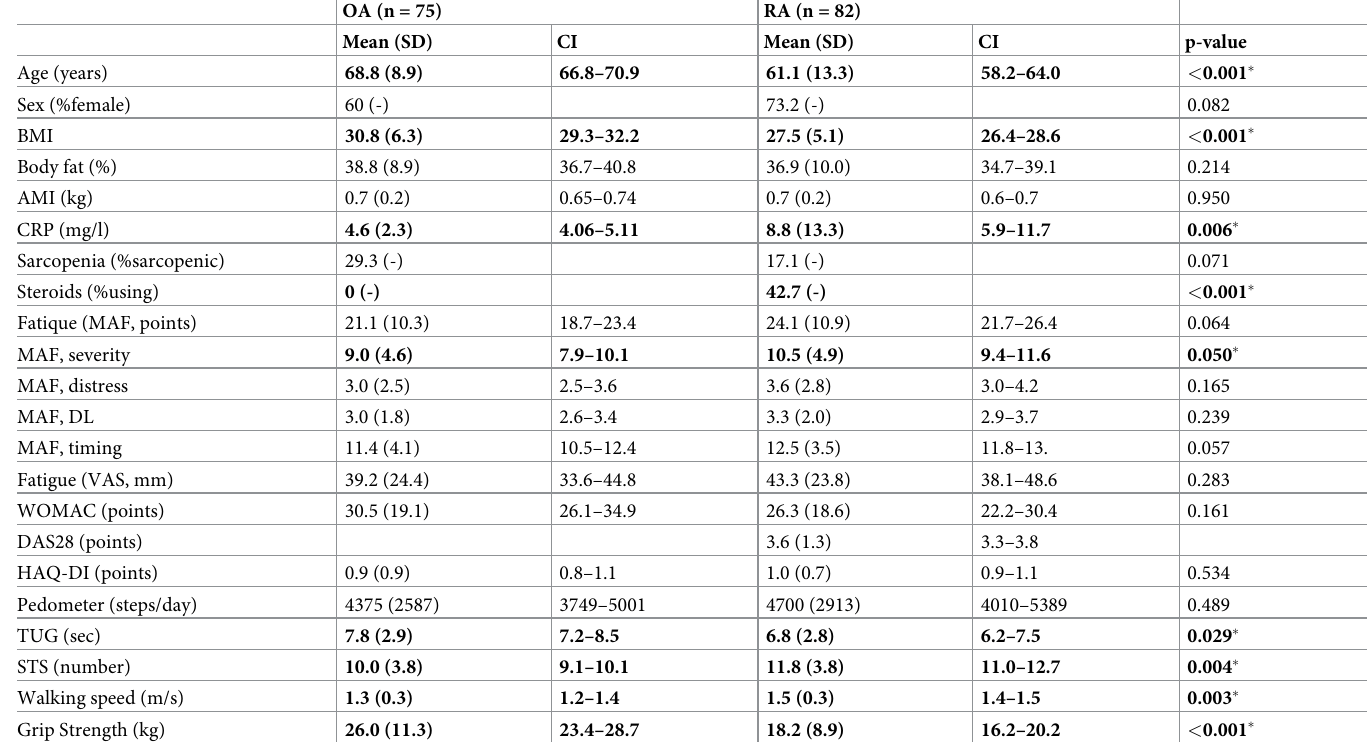
Table 1. Participant